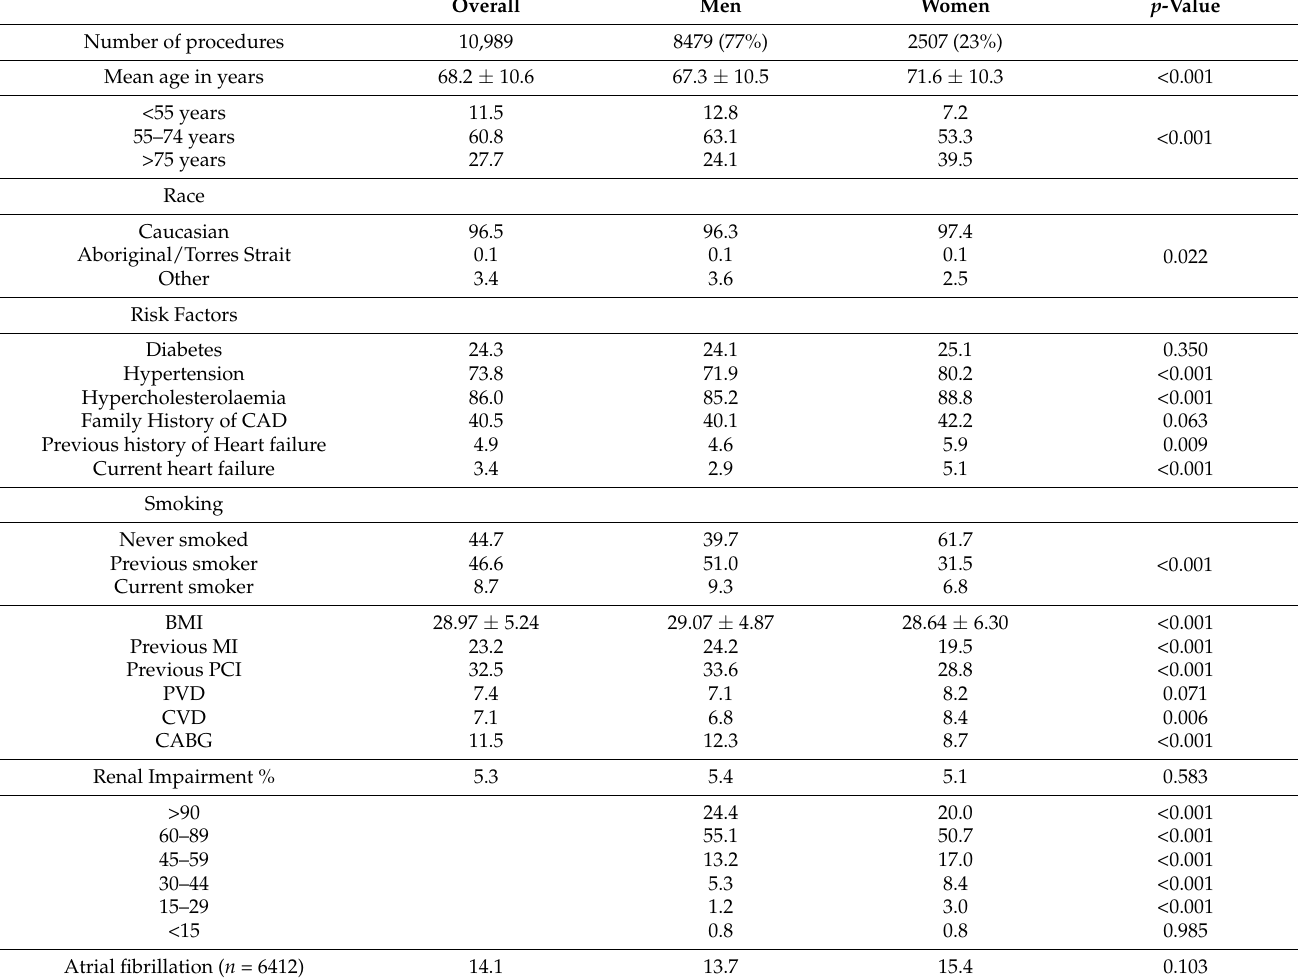
Table 1. Demographics and risk